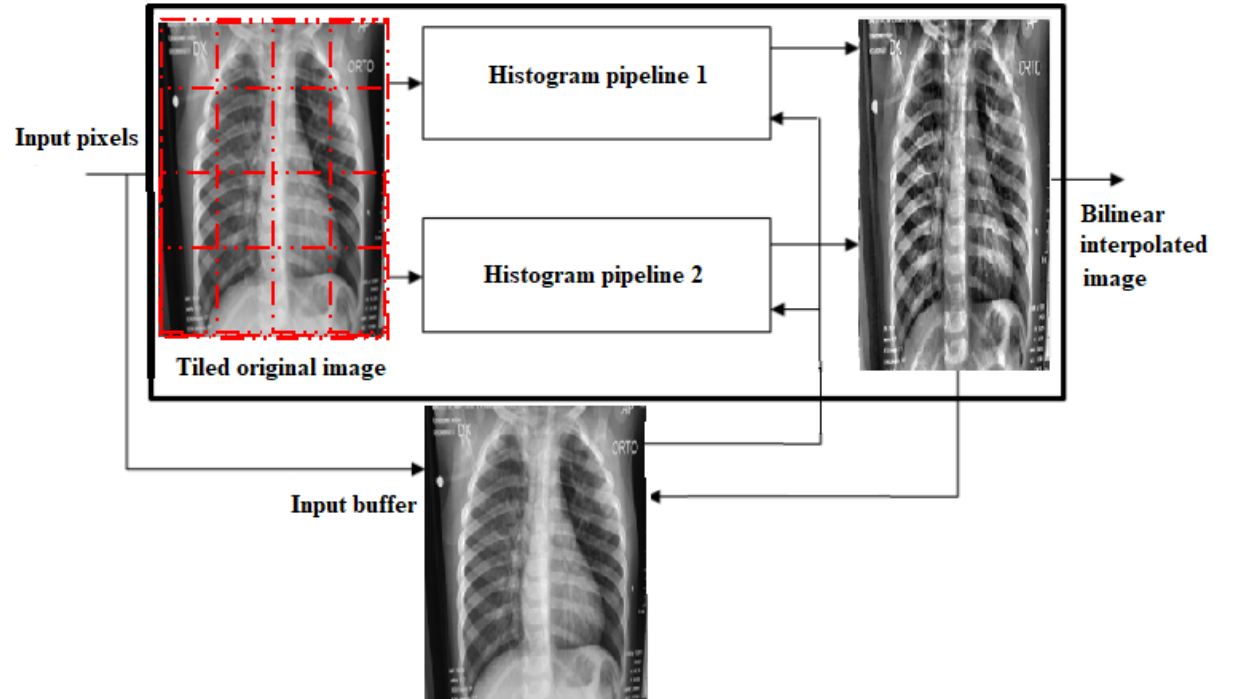
Figure 5. The CLAHE model on lung X-ray